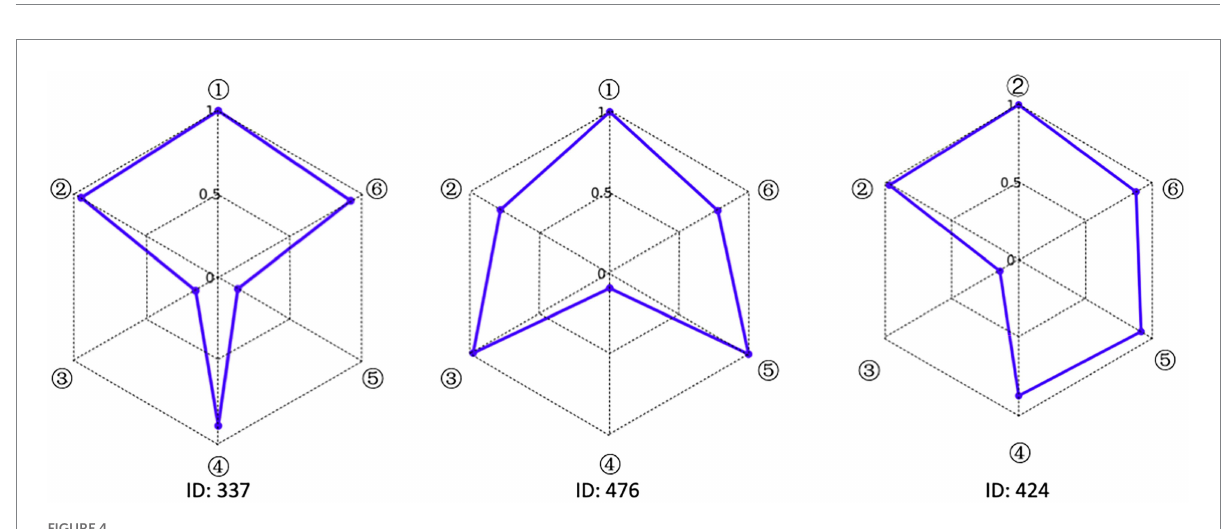
FIGURE 4 Radar chart of the mastery results of students’ data analysis